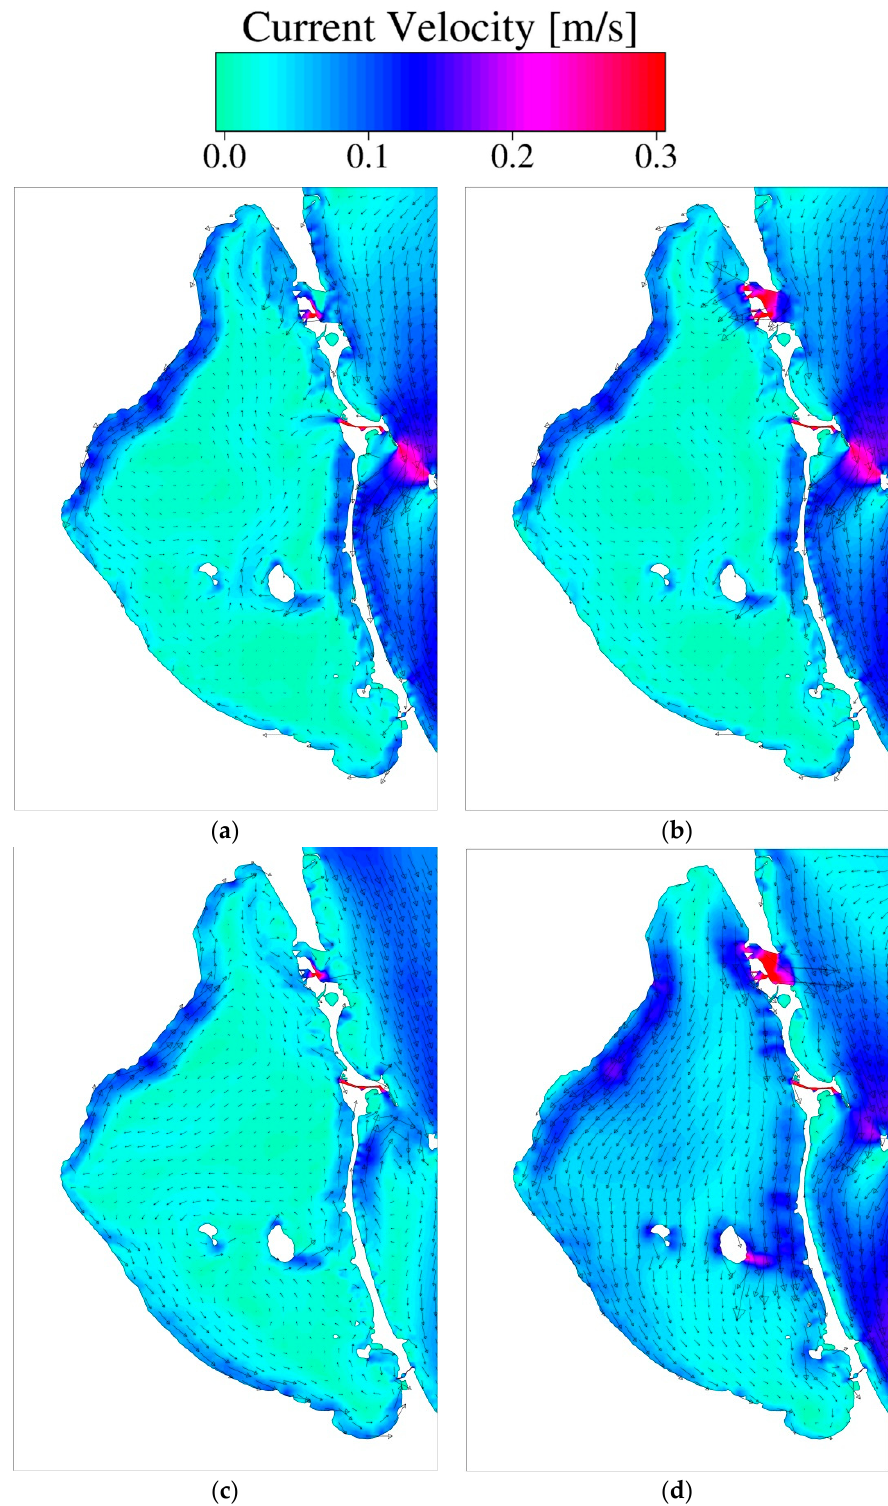
Figure 10. Vertically averaged current speeds at maximum discharge through El Estacio towards the lagoon ( a ) Undisturbed; ( b ) Enc_1m, and out of the lagoon: ( c ) Undisturbed, and towards the Mediterranean ( d ) Enc_1m.